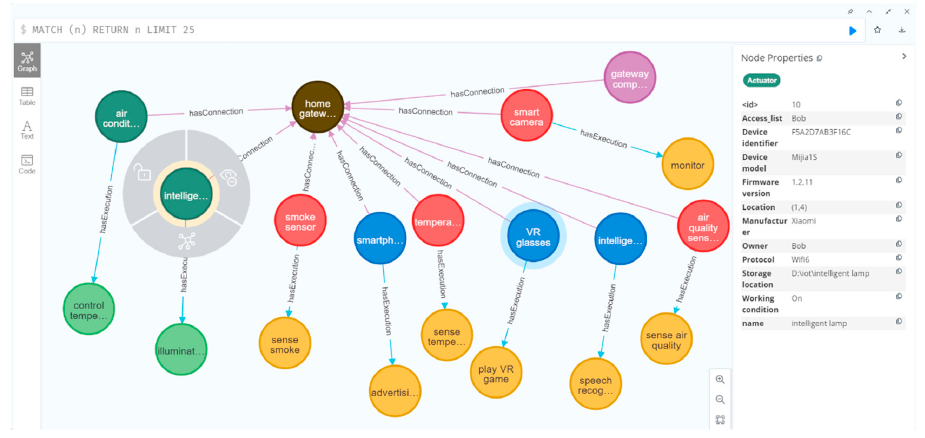
Figure 15. Updated network twin.